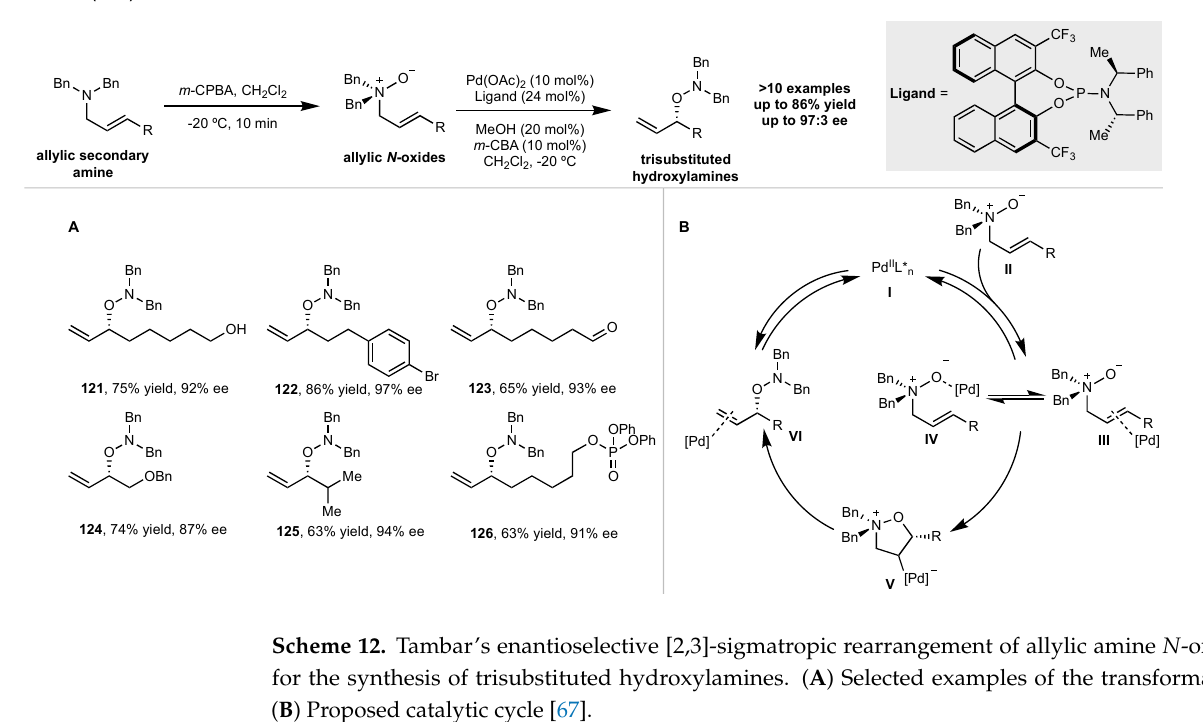
Scheme 12. Tambar(cid:31)s enantioselective [2,3]-sigmatropic rearrangement of allylic amine N -oxides for the synthesis of trisubstituted hydroxylamines. ( A ) Selected examples of the transformation. ( B ) Proposed catalytic cycle [67]